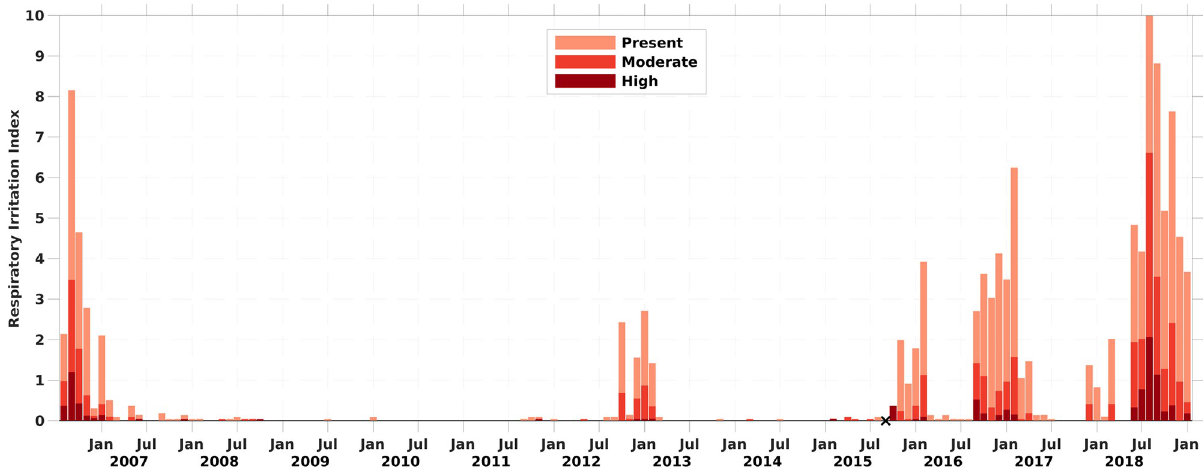
Fig 6. Monthly respiratory irritation impact (RI) index for Manatee and Sarasota Counties, FL from August 2006-January 2019. The RI index was defined by the number of station days for each respiratory irritation impact condition (present or slight, moderate, and high) and normalized by the highest RI to fall in a range of 0–10 (zero means that no beach experienced respiratory irritation impact, and 10 as the maximum number of beach days). Black Xs on the X-axis show months with no available BCRS data